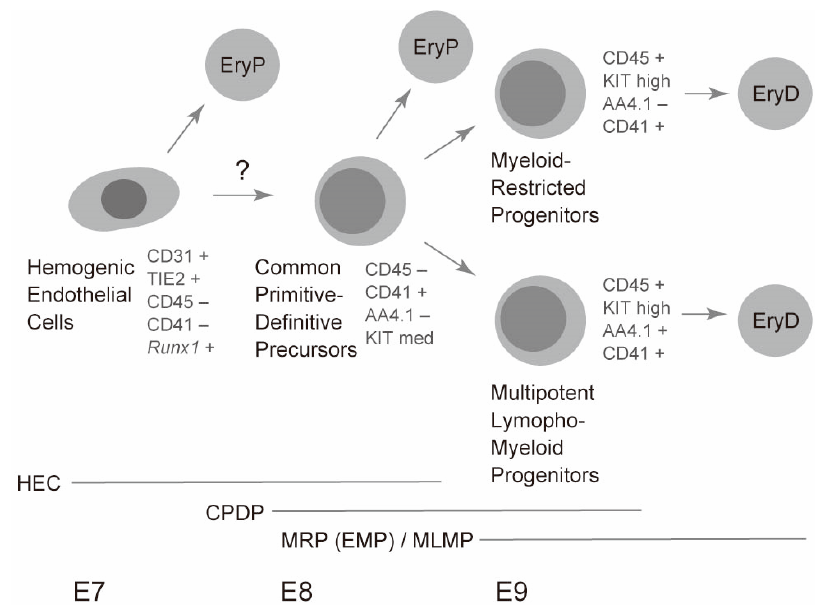
Figure 2. A model of erythropoiesis in the yolk sac. Timeline of erythropoiesis is schematically described along with the embryonic day of mouse development (E7–E9). Representative marker expression is shown along with the cell population names. Periods when each cell population are present are shown by horizontal bars. EryP, primitive erythrocytes; EryD, definitive (adult-type) erythrocytes; HEC, hemogenic endothelial cells; CPDP; common primitive-definitive precursors; MRP, myeloid-restricted progenitors; EMP, erythroid-myeloid progenitors; MLMP, multipotent lympho-myeloid progenitors.